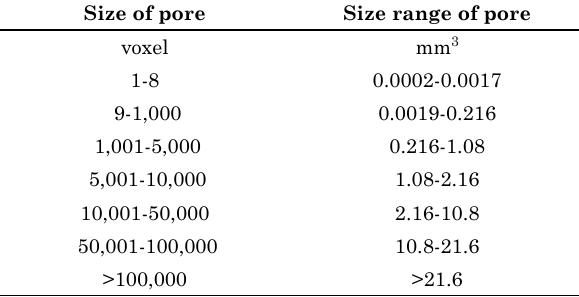
table 2. classification of pores regarding size